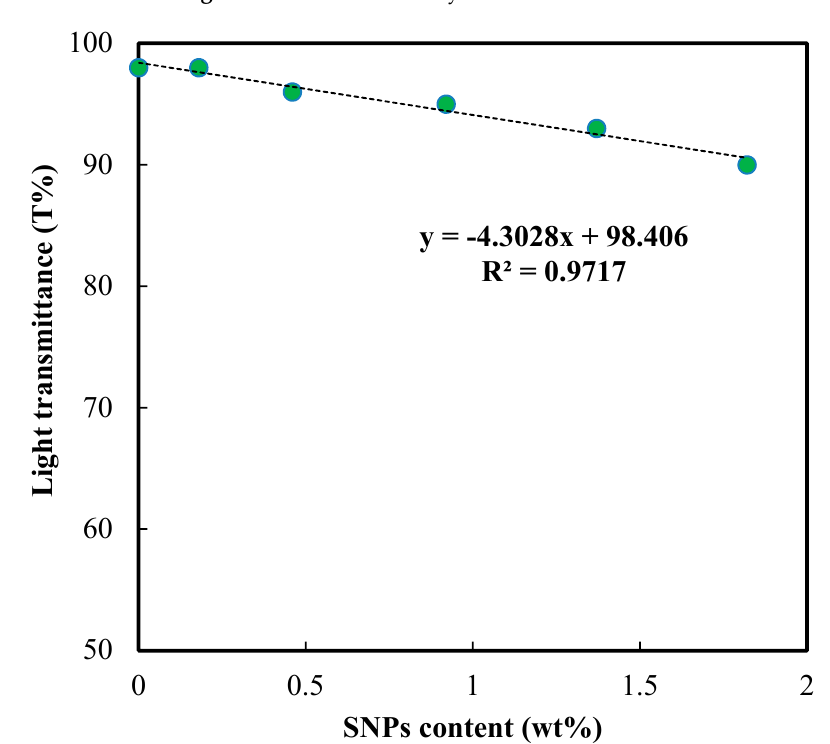
Figure 6. Effect of SNPs content on optical transparency.